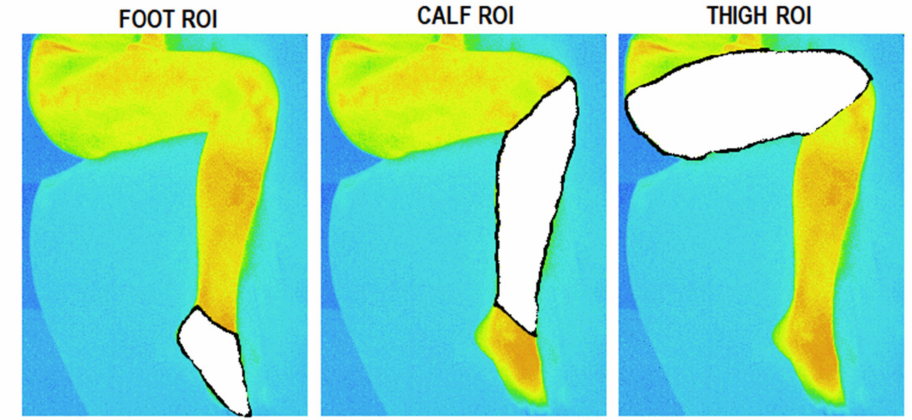
Figure 4. The result of manual procedure A: ROI mask creation for FOOT, CALF, and